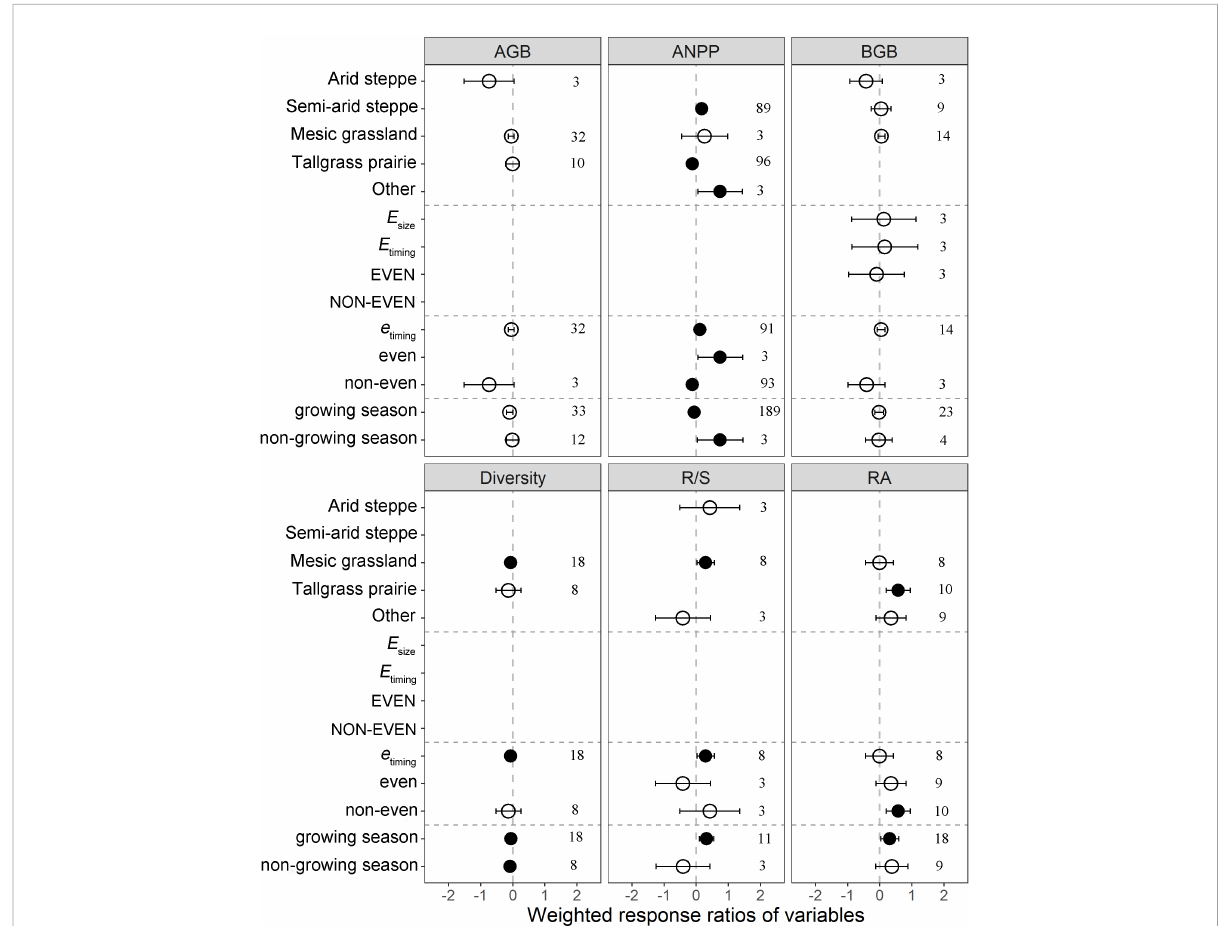
FIGURE 3 Subgroup analysis of plant productivity and community structure on altered intra-annual precipitation patterns. Between-group heterogeneity ( Q B ) was tested according to ecosystem type, precipitation distribution and experimental period. If 95% CI did not overlap with zero, the effects of precipitation pattern on variables were considered signi fi cant (denoted by black circles). Error bars represent 95% con fi dence intervals (CI). The vertical dashed line represents weighted response ratios = 0. Numbers indicate the number of data observations. The Q B statistical test was used to compare the differences in weighted response ratios among groups divided by ecosystem type, precipitation distribution and experimental period. A signi fi cant Q B value ( p < 0.05) suggested that the weighted response ratios of a given variable differed among groups. E E szie , even event size treatment; timing , even event timing treatment; EVEN, even event size and timing treatment; NON-EVEN, non-even event size and timing treatment; e timing , even event timing treatment; even, even event size and timing treatment; non-even, non-even event size and timing treatment. See Figure 2 for